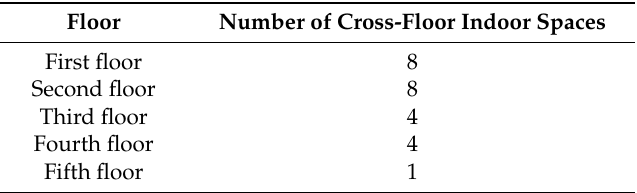
Table 4. Number of cross-floor indoor spaces in the experimental data.